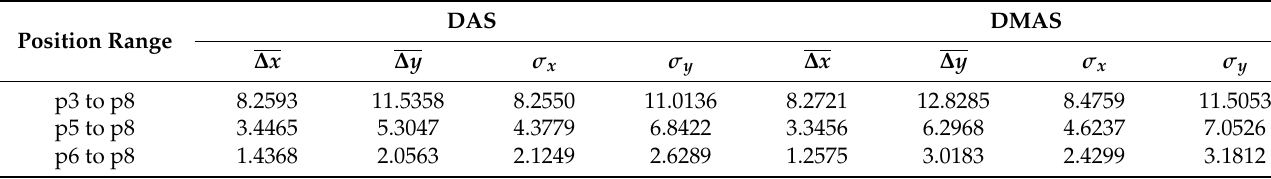
Table 2. Error analysis for both algorithms (data in mm).